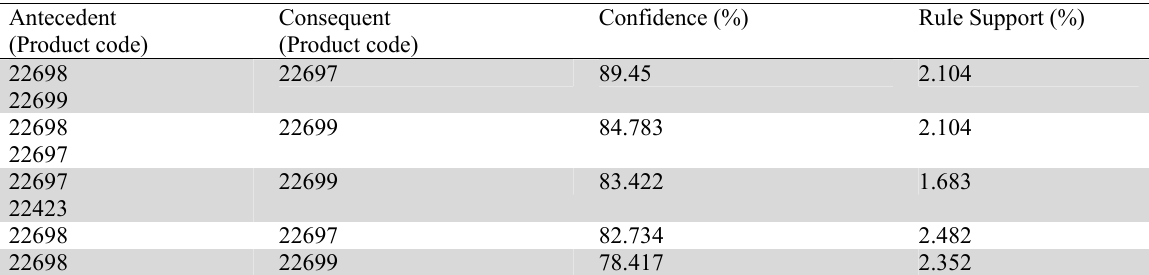
Association rules for scenario 1 in situation 1